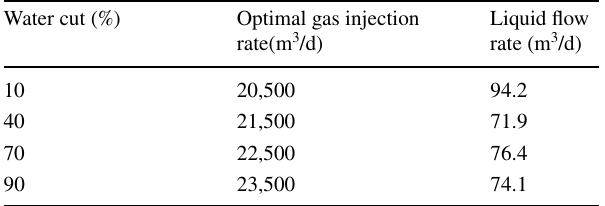
Fig. 4 Choosing the optimal operation regime of the gas-lift well Table 7 Determination of optimal compressed gas injection rate for various water